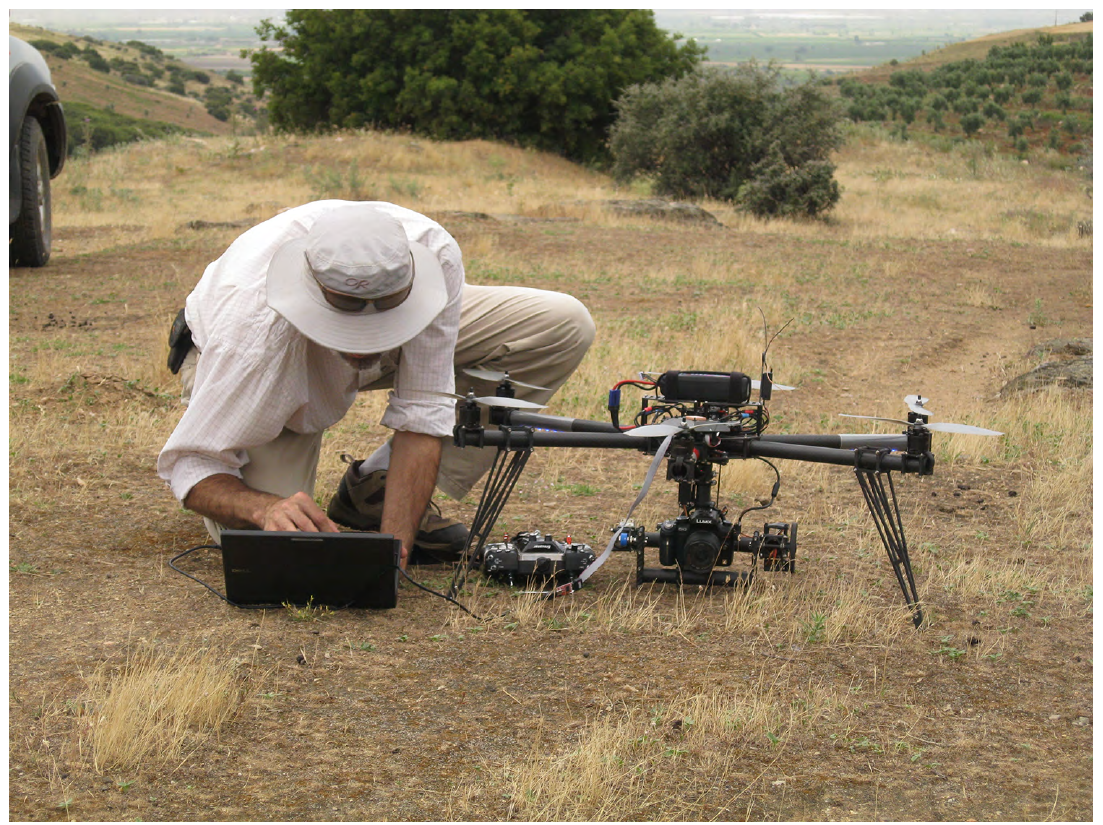
Figure 5: The Cinestar 6 hexacopter with mounted camera at Koca